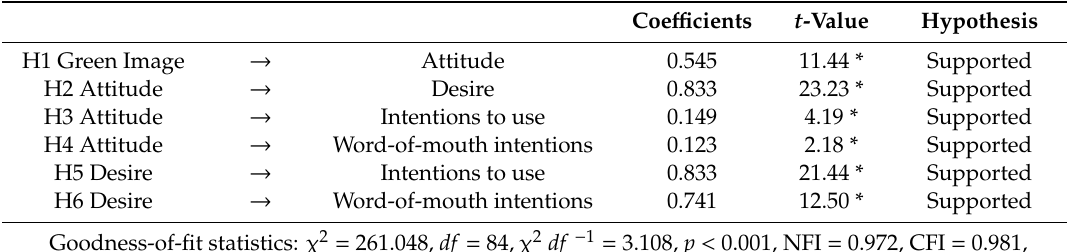
Table 3. Standardized parameter estimates for structural